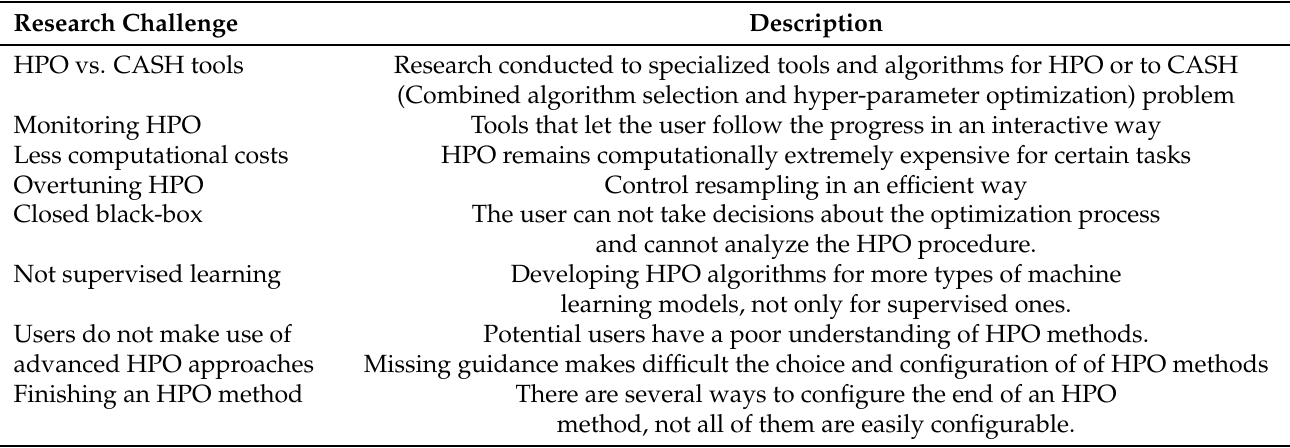
Table 1. Open research challenge in HPO. Content extracted from [3].